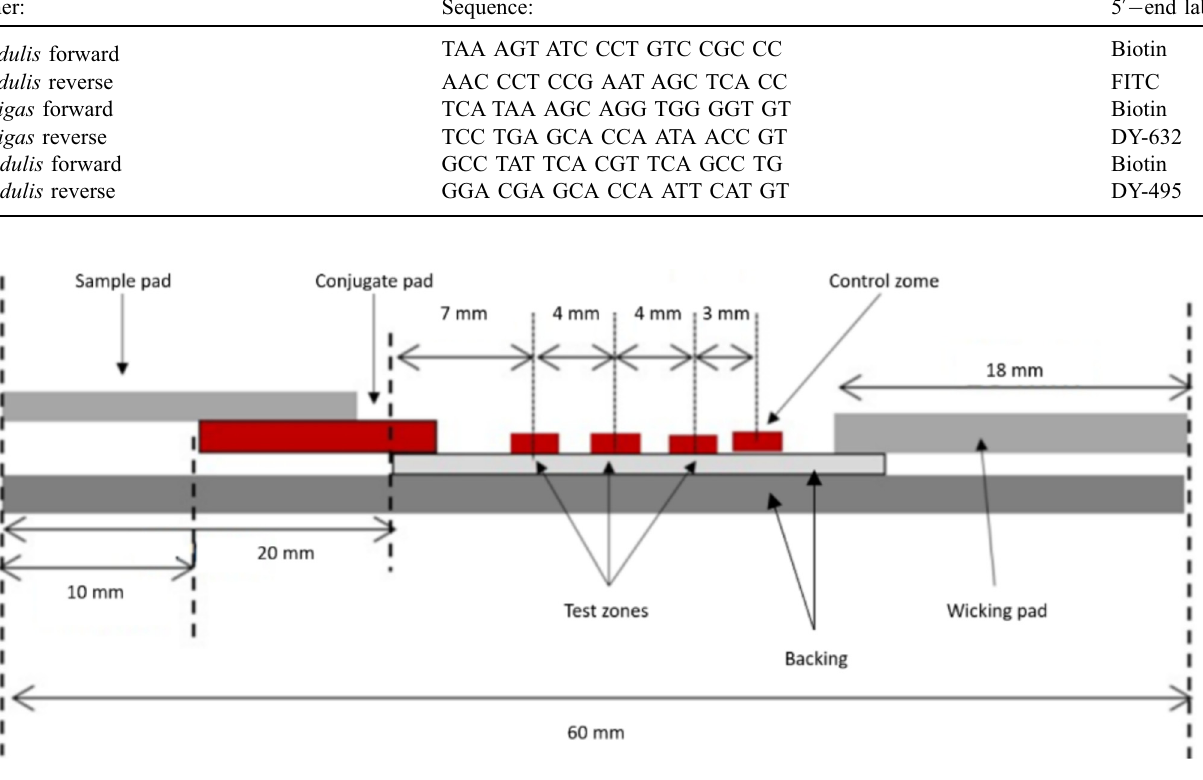
Fig. 1. Schematic illustration of the lateral fl ow test stripes with the exact location of the different zones. (Modi fi ed after Senova Gesellschaft für Biowissenschaft und Technik